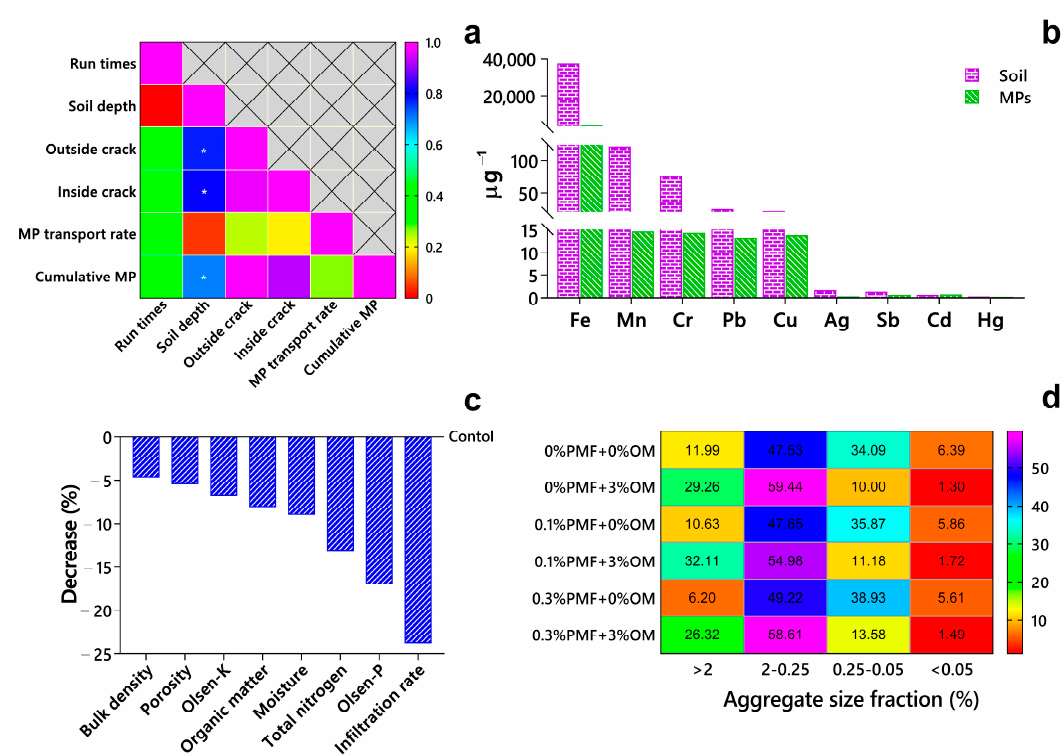
Figure 3. Impact of MPs/NPs on soil properties. ( a ) Correlation analysis (rainbow heatmap) of irrigation impacted MPs migration in a soil column (based on data from Zhao et al. [164]) (* indicates negative correlation). ( b ) Heavy metal content (mean values) of soil and MPs (based on data from Zhou et al. [165]). ( c ) Response of soil properties to MPs at concentrations ranging from 0.01 to 640,000 mg kg ‒ 1 (meta ‐ analysis data from Gao et al. [20]). ( d ) Soil aggregate size fractions (%) as influenced by MPs (polyester microfibers) and soil organic matter (based on data from Zhang et al. [143]).